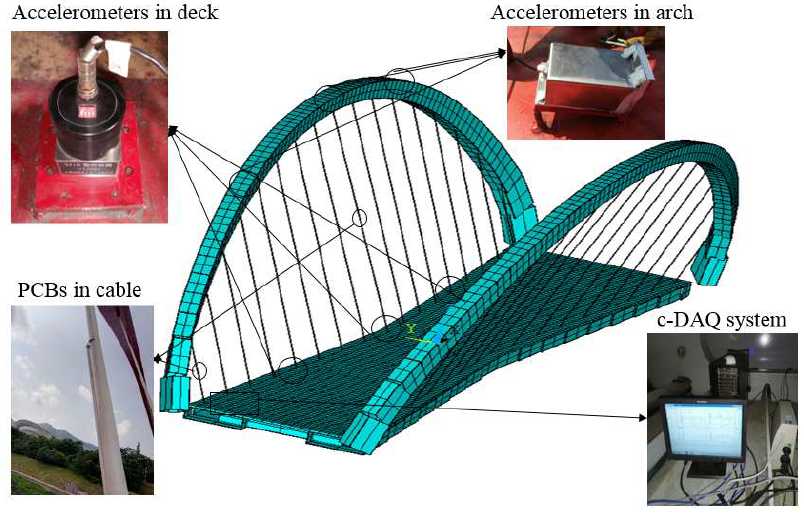
Figure 12. The continuous dynamic system.